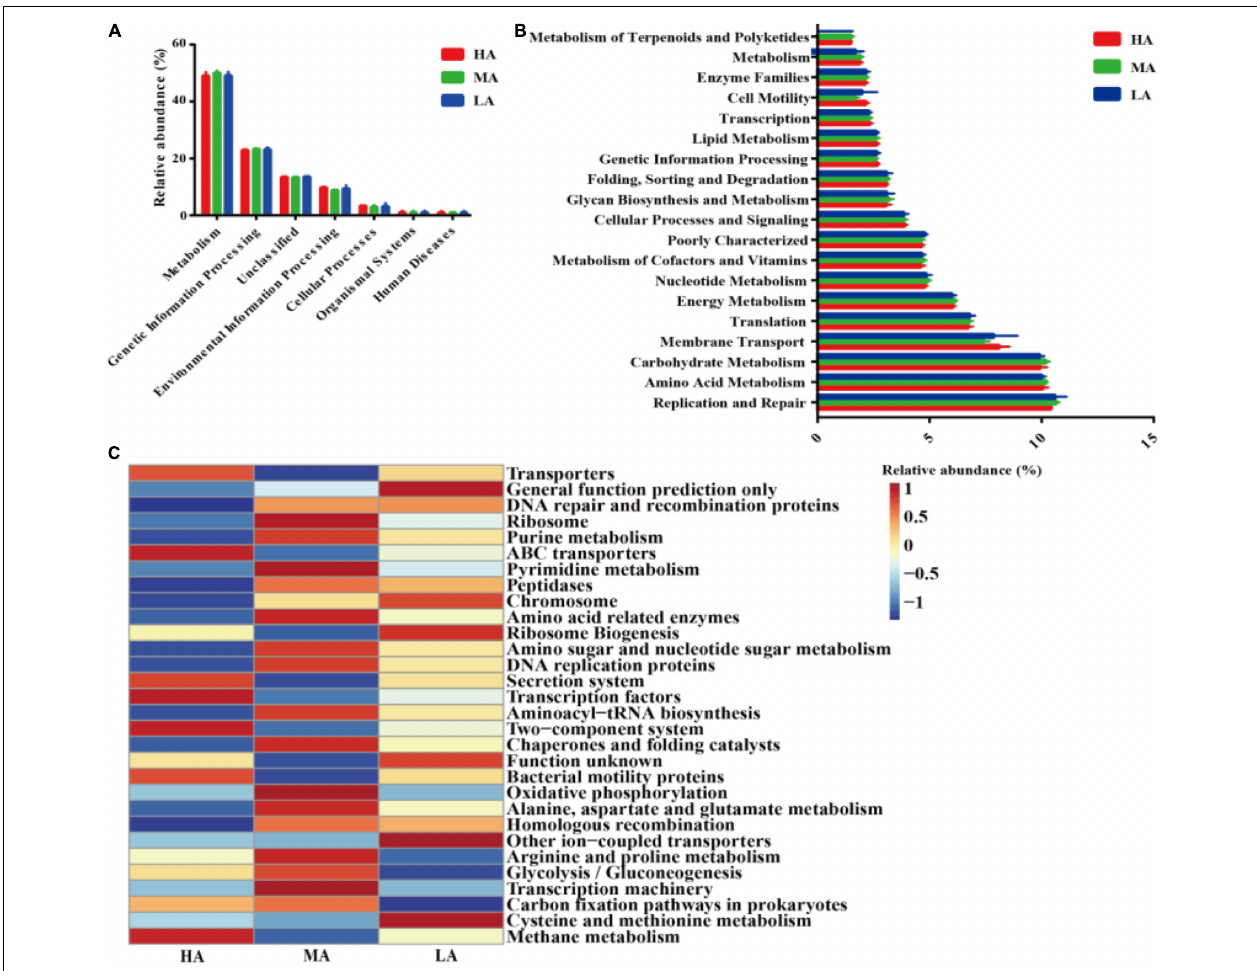
FIGURE 4 | Dynamics of rumen bacterial functional profiles fed with different diets analyzed by PICRUSt ( n = 3). (A) Level 1 metabolic pathways. (B) Level 2 Kyoto Encyclopedia of Genes and Genomes (KEGG) ortholog functional predictions of the relative abundances of the top 20 metabolic functions. (C) Level 3 KEGG ortholog functional predictions of the relative abundances of the top 30 metabolic functions. HA, high alfalfa percentages group; MA, middle alfalfa percentages group; LA, low alfalfa percentages